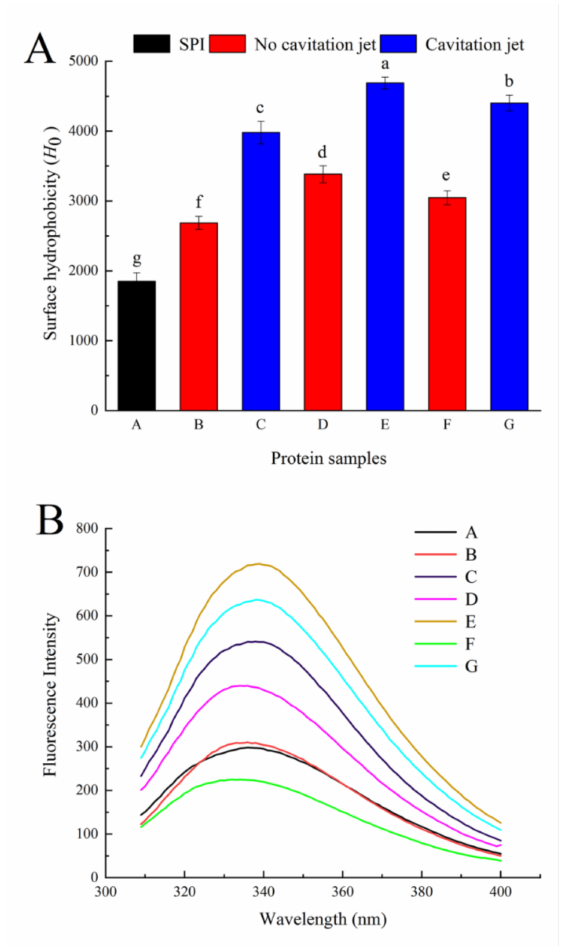
Figure 2. Surface hydrophobicity ( H 0 , A ) and intrinsic fluorescence emission spectrum ( B ) of oxidized SPI before and after cavitation jet treatment. Columns with different letters (a–g) are significant differences ( p <